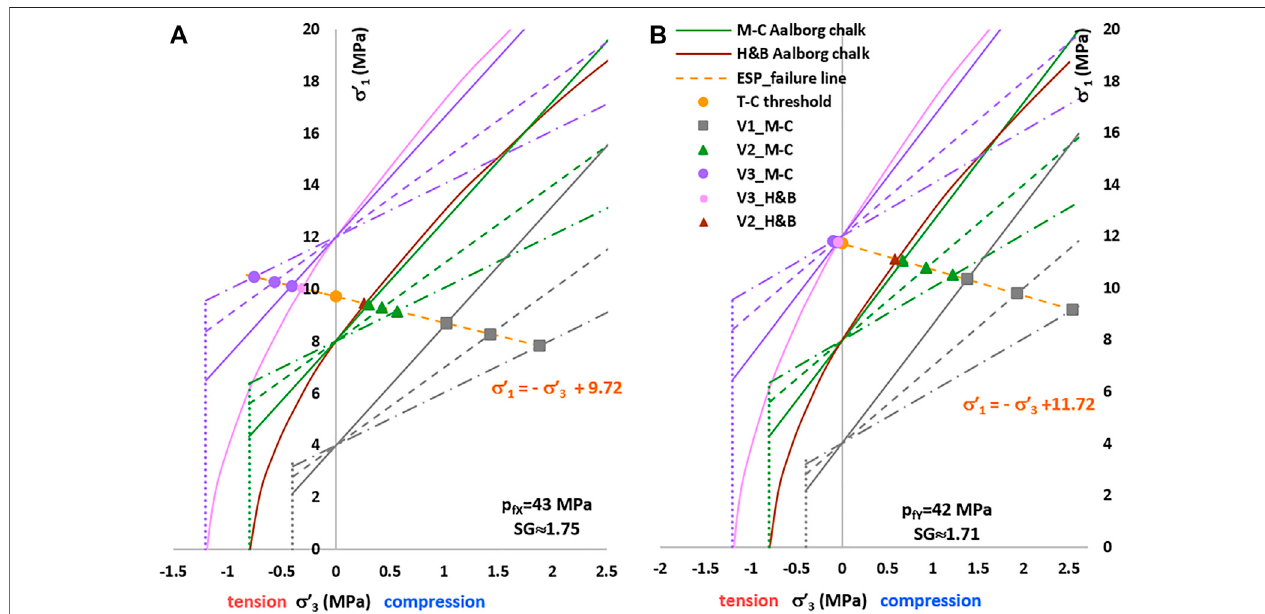
FIGURE9| Strength envelopesofthechalkwith σ c =4-8-12 MPa,and σ c / σ t ≈ 10.Thepink,brown,and turquoiselinesrepresent theH&Bstrengthenvelopeswith m t =10.Theviolet,green,andgreylinesrepresenttheM-Cstrengthenvelopeswith ϕ ′ =20 ° -30 ° -40 ° .Theprincipalstressesare σ ′ r =P w − p f = σ ′ 3 and σ ′ ϑ =S − P w − p f = σ ′ 1 . Depth z = 2,500 m. (A) Reduced pore pressure p fX = 43 MPa. (B) Reduced pore pressure p fY = 42 MPa.